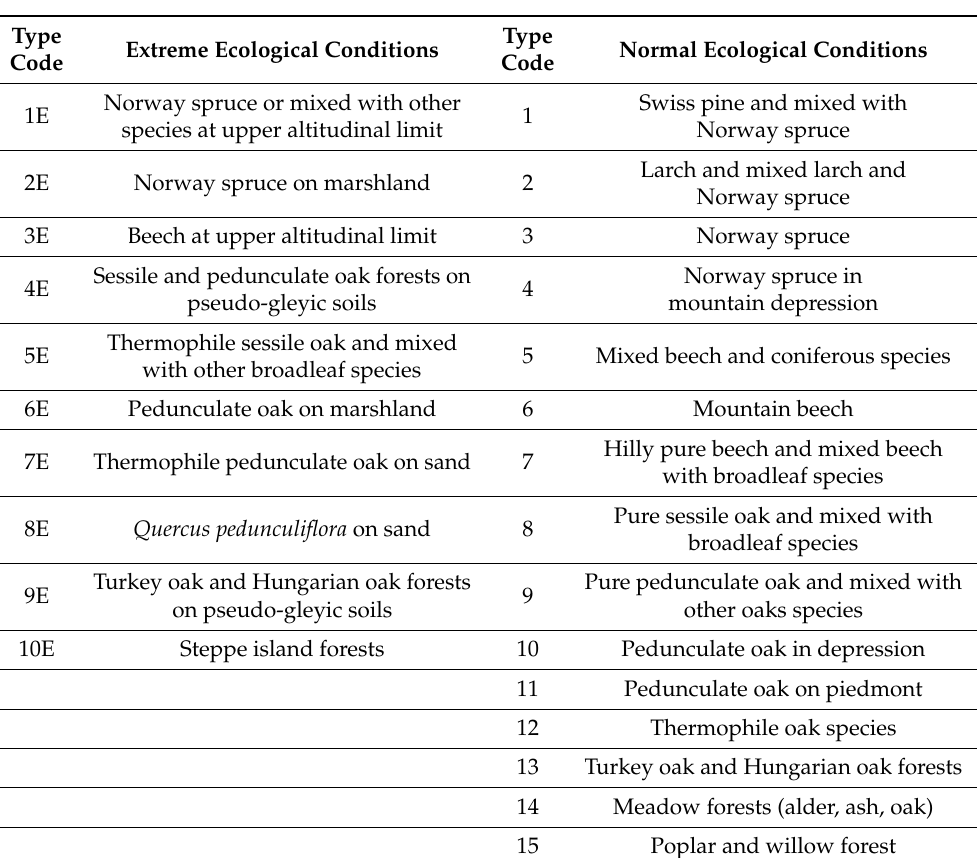
Table 4. The main forest